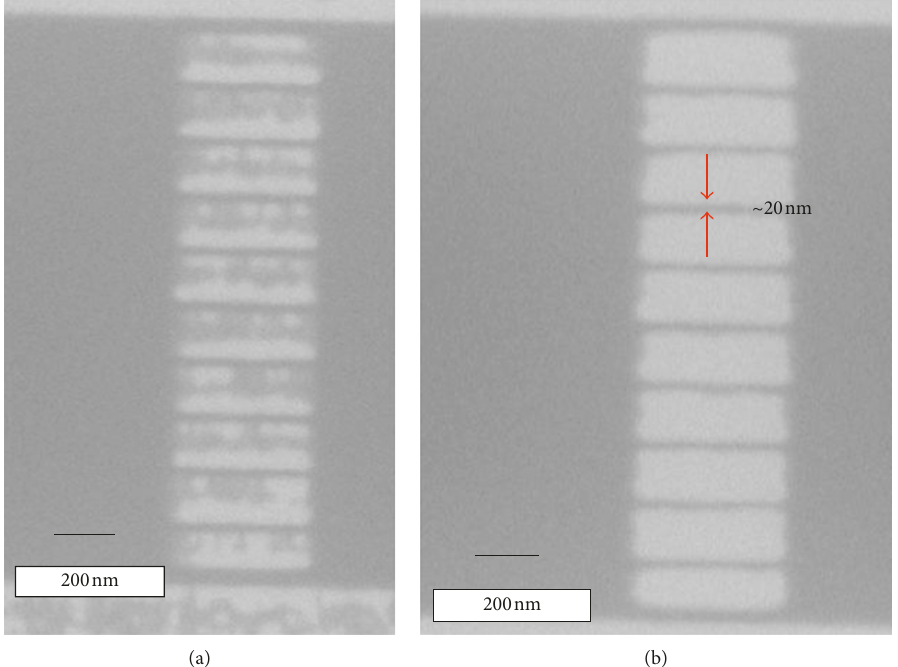
Figure 4: PMMA ribbon ( ∼ 20 nm width) patterns on silicon dioxide (SiO 30mTorr, 1sccm, 2